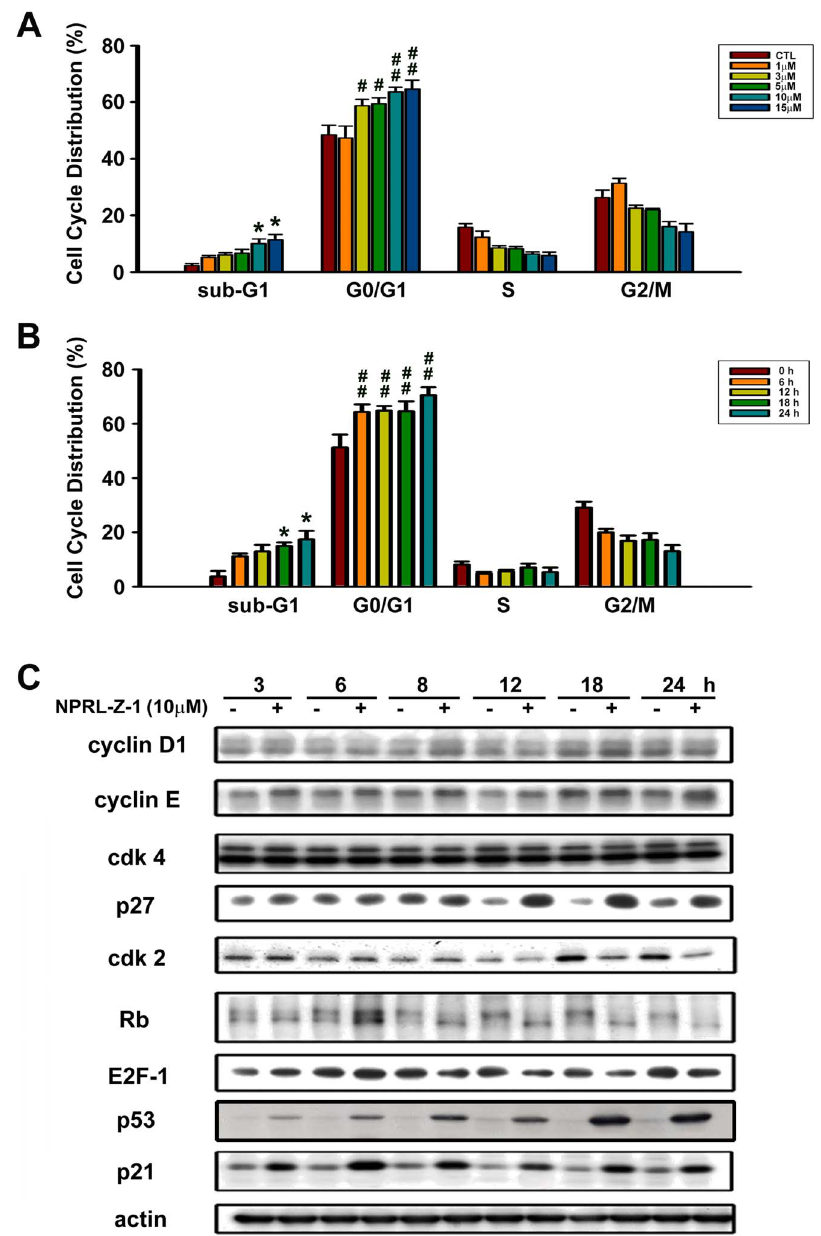
Figure 3. Effects of NPRL-Z-1 on cell cycle distribution and expression of cell cycle-related proteins in A498 cells. Cells were incubated with (A) DMSO or various concentrations of NPRL-Z-1 for 24 h and (B) DMSO or 10 m M NPRL-Z-1 for the indicated time periods. Cell cycle phase and cell apoptosis were determined by FACS as described in Materials and Methods. (C) A498 cells were incubated with DMSO or 10 m M NPRL-Z-1 for the indicated time periods. After treatment, cells were harvested and lysed for detection of the indicated proteins via western blotting. Data are expressed as the mean percentage of control 6 S.D. of three independent experiments. * , # p , 0.05, and ## p , 0.01 compared with the control